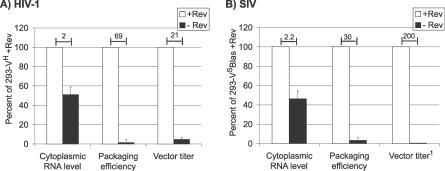
Effect of Rev on RNA Packaging in Cells Infected with HIV-1- or SIV-Based Vectors(A) HIV-1-based vectors. 293T cells stably infected with the VH vector were transfected with Hgpsyn and expression plasmids for VSV-G and HIV-1 tat in the presence (+Rev) or absence (−Rev) of the HIV-1 rev expression plasmid.(B) SIV-based vectors. 293T cells stably infected with VS-Blas were cotransfected with Sgpsyn and VSV-G and tat expression plasmids in the presence or absence of the rev expression plasmid. Cytoplasmic RNA levels, packaging efficiencies, and vector titers are presented relative to those obtained in the same transfection experiment in the presence of Rev.The mean value and standard deviation of three independent transfection experiments are shown. Numbers above the bars indicate fold induction by Rev. 1, result of single transfection experiment.